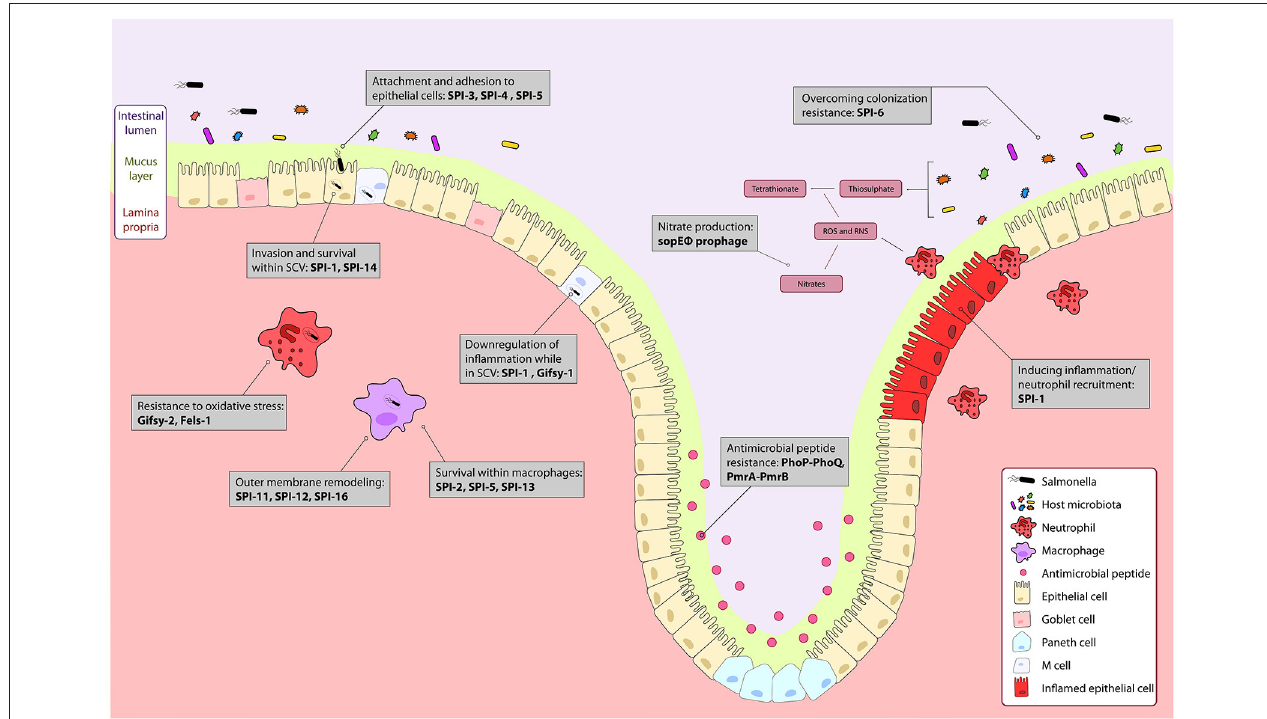
FIGURE 1 | The course of Salmonella infection within the intestine is driven by horizontally acquired virulence factors. Genes encoded on the horizontally acquired Salmonella Pathogenicity Islands (SPIs) and prophage associated genes are important during Salmonella infection of the intestine. Salmonella colonizes the intestinal lumen through activation of robust inflammation by genes encoded on the sopE prophage, and SPI-1 secreted effectors, and outcompetes commensal microbes metabolically, and with a type 6 secretion system encoded on SPI-6. The PhoPQ and PmrAB two-component systems regulate resistance to luminal antimicrobial peptides. Surface proteins encoded on SPI-3 and SPI-4 drive attachment to epithelial cells, and bacterial mediated endocytosis into epithelial cells is induced by gene products from SPI-1 and SPI-5. Modification of the bacterial endosome and survival within the Salmonella containing vacuole (SCV) is driven by SPI-1 and the Gifsy-1 prophage. Within the SCV and in immune cells like neutrophils and macrophages, resistance to immune responses such as oxidative stress is mediated by the Gifsy-2 and Fels-1 prophages, and SPI-11, SPI-12, and SPI-16 that remodel the outer membrane to evade immune responses. Survival within macrophages is mediated by SPI-2, SPI-5, SPI-13. Together, these genes allow for colonization and systemic infection of Salmonella Typhimurium.